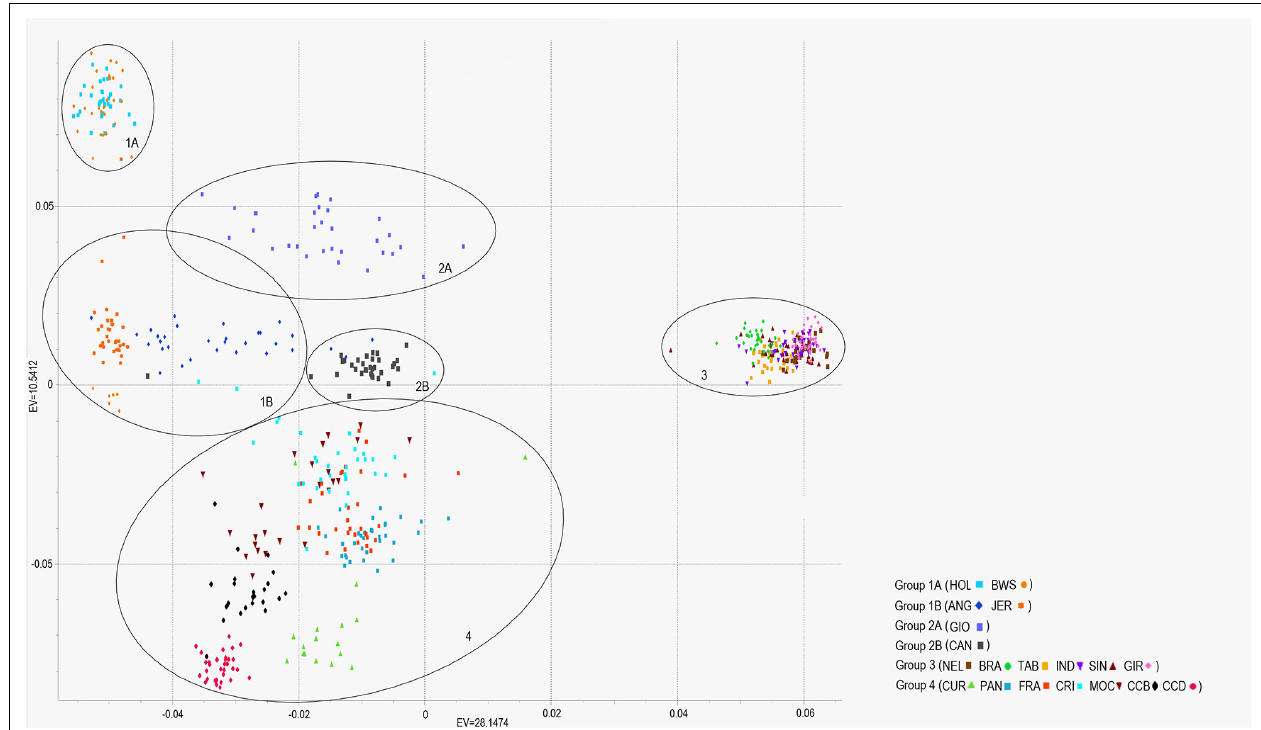
FIGURE 7 | PCAs showing the relationships between nineteen cattle breeds raised in Brazil. Breeds are separated into six groups (oval circles), being taurine (groups 1A and B), synthetic crossbred (groups 2A and B), indicine (group 3), and locally adapted (group 4). Breeds are labeled as Canchim (CAN), Brahman (BRA), Sindhi (SIN), Nelore (NEL), Tabapuã (TAB), Indubrasil (IND), Gir (GIR), MochoNacional (MOC), Caracu Dairy (CCD), Caracu Beef (CCB), Pantaneiro (PAN), CurraleiroPé-Duro (CUR), CriouloLageano do RS (FRA), CriouloLageano (CRI), Girolando (GIO), Holstein (HOL), Brown Swiss (BWS), Jersey (JER), and Angus